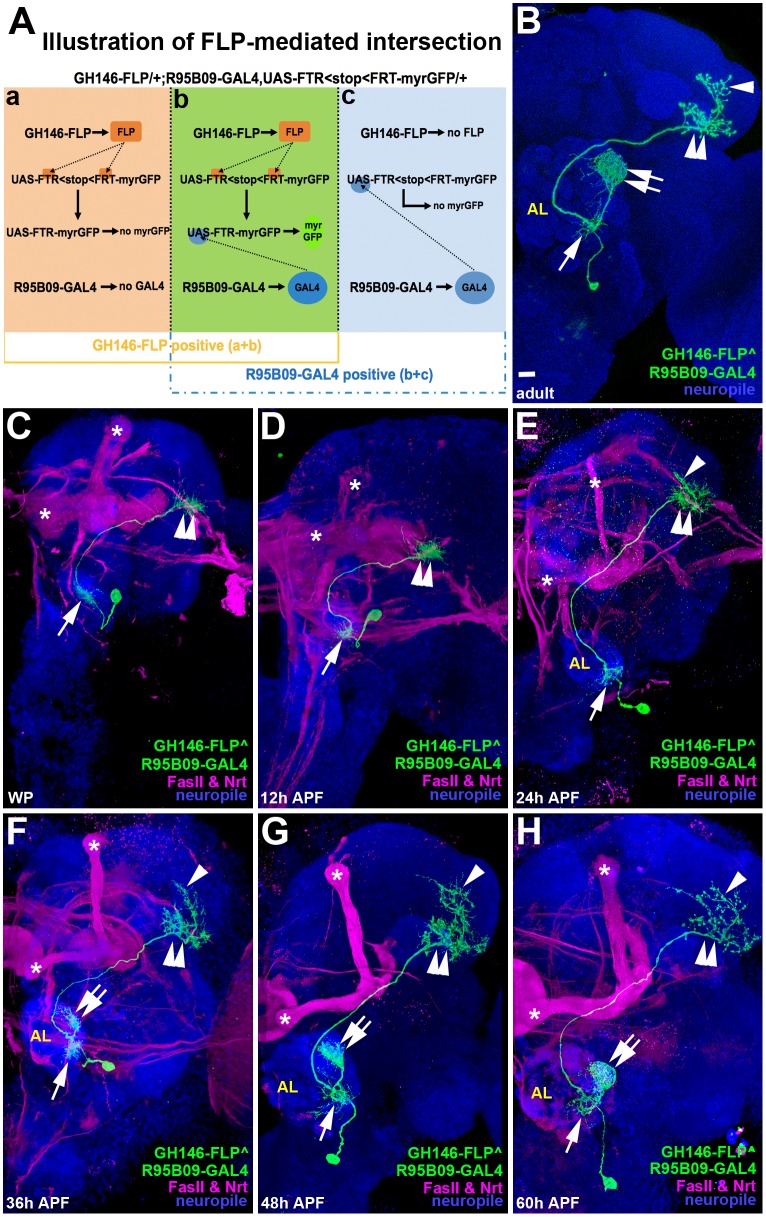
Use of an intersection strategy to visualize the developing DA1 vPN.(A) A schematic illustration of how to obtain a pure DA1 vPN expression pattern by intersecting the expression of a membrane bound GFP reporter, myristoyl-anchored GFP (myr-GFP) reporter, with R95B09-GAL4 and GH146-FLP. All neurons contain the genetic components of GH146-FLP, R95B09-GAL4 and UAS-FRT<stop<FRT-myr-GFP in the genome. However, the expression of myr-GFP is initially blocked by the presence of a FRT<stop<FRT cassette. GH146-FLP is expressed to remove this stop cassette in neurons of panels a and b but not in those of panel c. On the other hand, R95B09-GAL4 is expressed in neurons of panel b and c but not in those of panel a. Therefore, myr-GFP can be only expressed in neurons of panel b in which GH146-FLP and R95B09-GAL4 are co-expressed. (B) A flattened confocal image revealed the pure DA1 vPN expression pattern that was obtained by intersecting R95B09-GAL4 and GH146-FLP. Dense and loose dendritic innervations in the DA1 glomerulus and the ventral portion of the AL were pointed by double-arrow and arrow, respectively. Characteristic dorsal and ventral axonal branches were indicated by arrowhead and double-arrowhead, respectively. (C-H) The morphogenesis of the developing DA1 vPN can be observed in confocal images taken from the brains of Drosophila in which R95B09-GAL4 was intersected with GH146-FLP; brains were processed at the following stages: white pupa (WP) (C), 12-hour (D), 24-hour (E), 36-hour (F), 48-hour (G), and 60-hour (H) after puparium formation (APF). In WP, axons and dendrites of the DA1 vPN were present at the ventral portions of the developing LH and AL, respectively. The characteristic dorsal axonal branches of the DA1 vPN started to appear around 24-hour APF (arrowhead in E) and became increasingly prominent afterward (arrowheads in F-H). Ventral axonal braches were also observed to elaborate after 24-hour APF (double-arrowheads in C-H). In contrast, the DA1 vPN dendrites remained at the ventrolateral developing AL prior to 36-hour APF (arrows in C-H) and started to elaborate dorsally in the developing AL at around 36-hour AFP (double-arrow in F). Gradually, the DA1 vPN dendrites accumulated at the dorsolateral part of the developing AL, with a resulting reduction of dendrites at the ventrolateral developing AL from 36-hour to 60-hour APF (double-arrows in F-H). The morphology of the developing DA1 vPN at 60-hour APF (H) was quite similar to that of the adult DA1 vPN (B). Brain neuropiles were stained with antibodies against Brp (A and B) or DN-cadherin (C-H) (shown in blue). Staining against FasII and Nrt (shown in magenta) was performed to reveal landmarks for comparison of the relative position of the developing DA1 vPN in C-H. Scale bar: 10 μm.